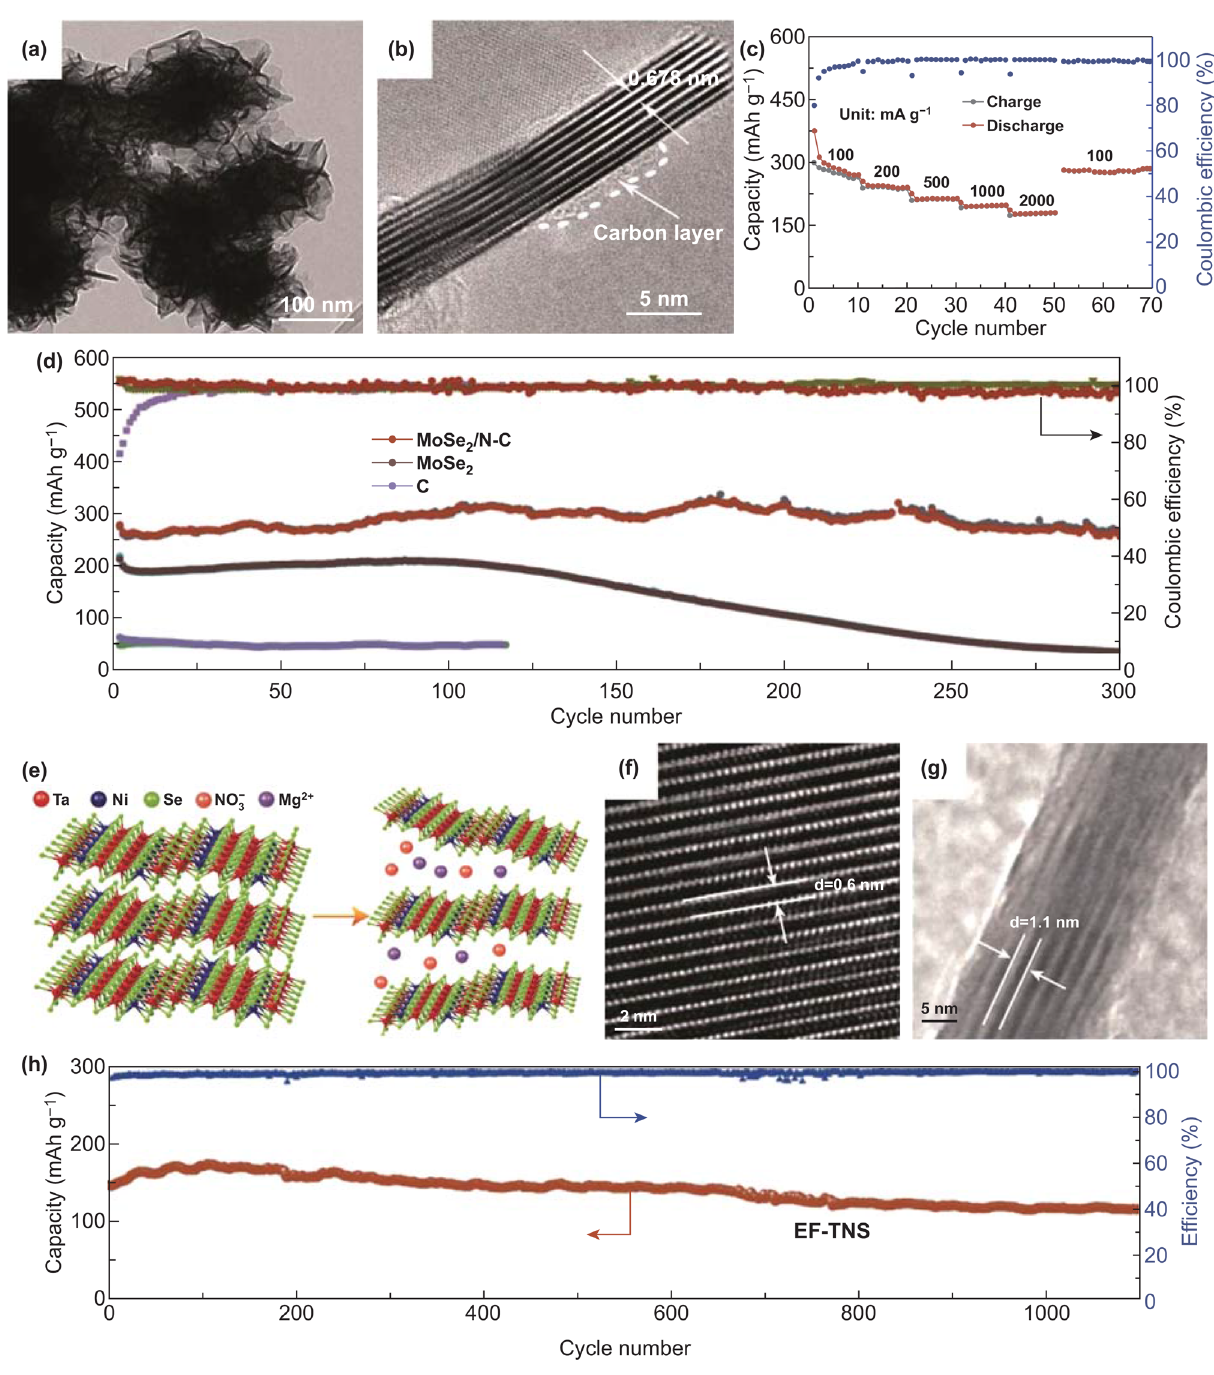
Fig. 10 a TEM image of MoSe 2 /N–C. b HRTEM image of MoSe 2 /N-C. c Rate capability of MoSe 2 /N-C from 100 to 2000 mA g −1 . d Long Cycle capacities of MoSe 2 /N-C, MoSe 2 , as well as C at 100 mA g −1 . Reproduced with permission from Ref. [67]. Copyright 2018, John Wiley and Sons. e Schematic diagram of expanding process of EF-TNS. f HRTEM image of pristine Ta 2 NiSe 5 . g HRTEM image of intercalated Ta 2 NiSe 5 . h Stable cycle capacities of EF-TNS anode at 500 mA g −1 . Reproduced with permission from Ref. [68]. Copyright 2019, John Wiley and